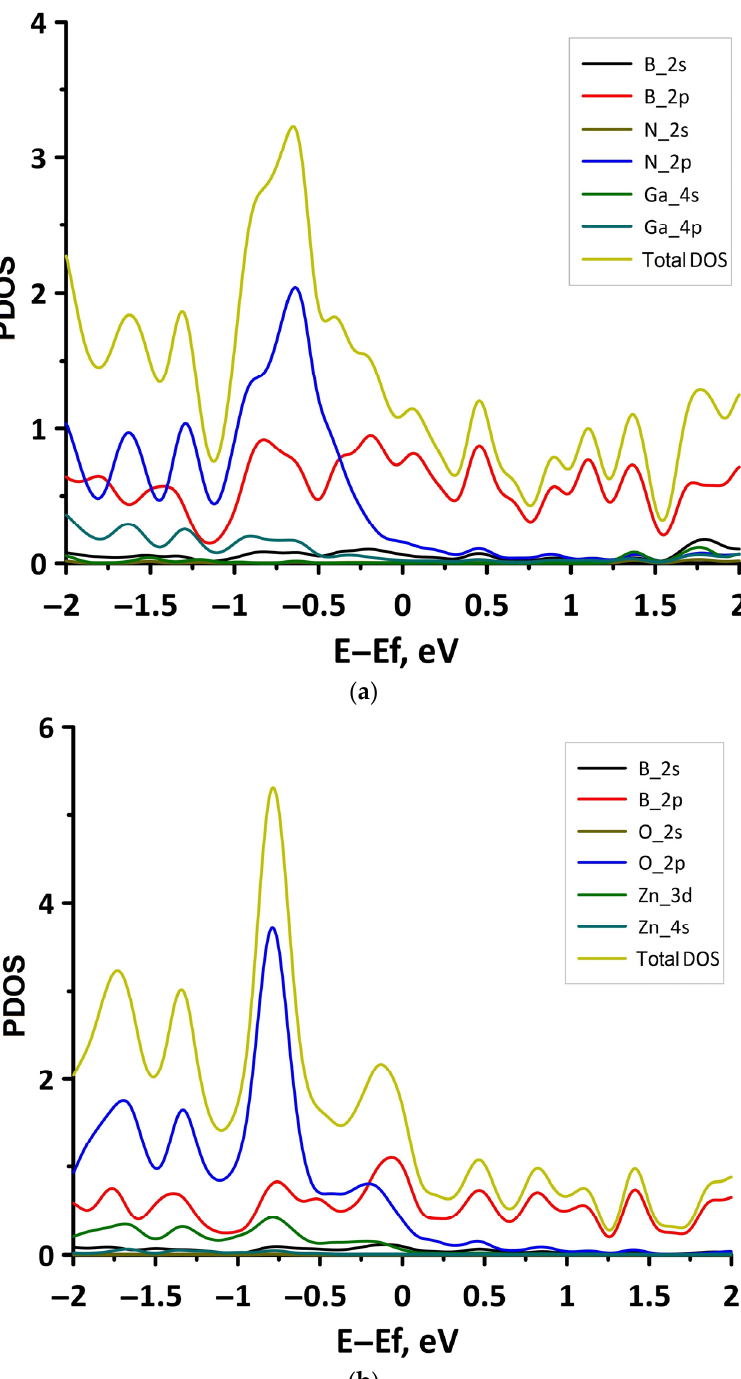
Figure 3. PDOS of borophene/GaN ( a ) and borophene/ZnO ( b ) van der Waals heterostructures.